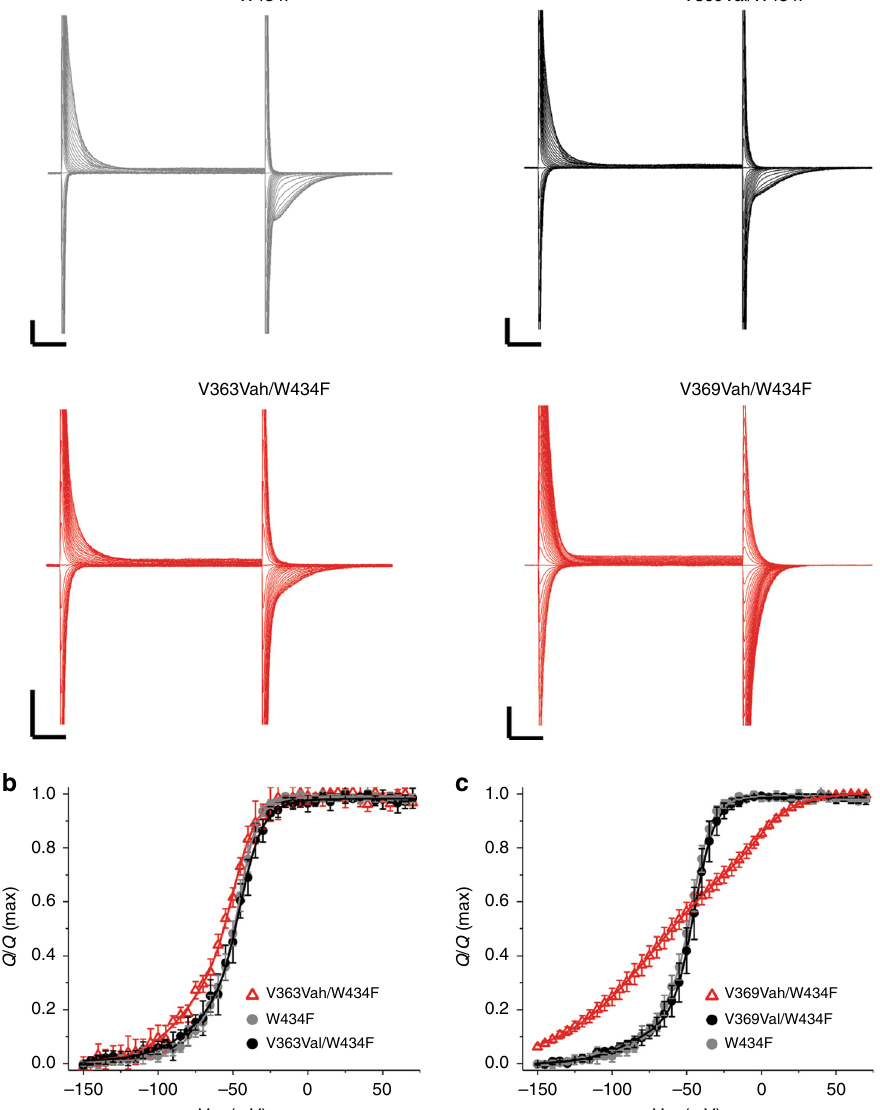
Fig. 4 A backbone ester mutation between R3 and R4 alters the movement of S4. a Exemplar traces showing gating currents and capacitance in response to membrane depolarizations for Shaker W434F and W434F/V369TAG co-injected with valine acylated tRNA (top) as well as W434F/V363TAG and W434F/V369TAG co-injected with valine α -hydroxy tRNA (bottom). For each trace, voltages between − 150 and 0 mV are displayed, with the exception of V369Vah/W434F, wherein − 150 to + 50 mV is shown. Scale bars denote 3 µ A ( Y- axis) and 5 ms ( X -axis). b Q - V relationship for V363Vah/W434F (red) compared to either the W434F or the V363Val/W434F control. Gating Q was extracted from traces by subtracting the linear capacitance from the integrated signal from the OFF currents 39 , Supplementary Figure 5. c Same as in b , but comparing Q - V relationships between V369Vah/W434F and either W434F or the V369Val/W434F control. All data shown in b, c are mean ± standard deviation from four to eight oocytes. Note the shallowing of the curve generated by the ester mutation at position 369, as well as the two visible components of gating